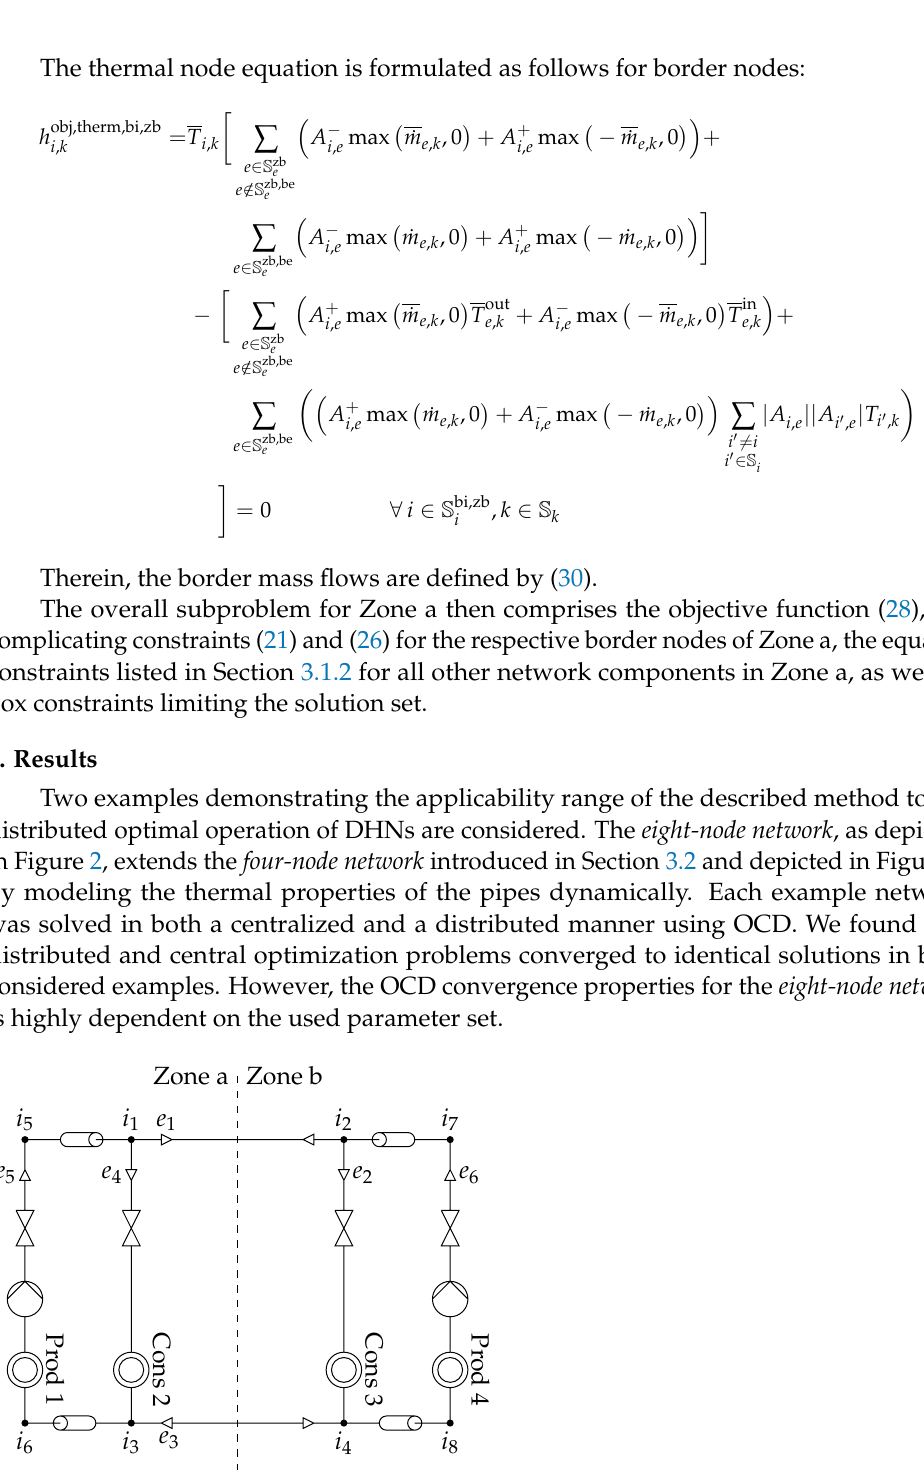
Figure 2. Example: eight-node network . DHN with eight nodes and dynamic elements decomposed into Zones a and